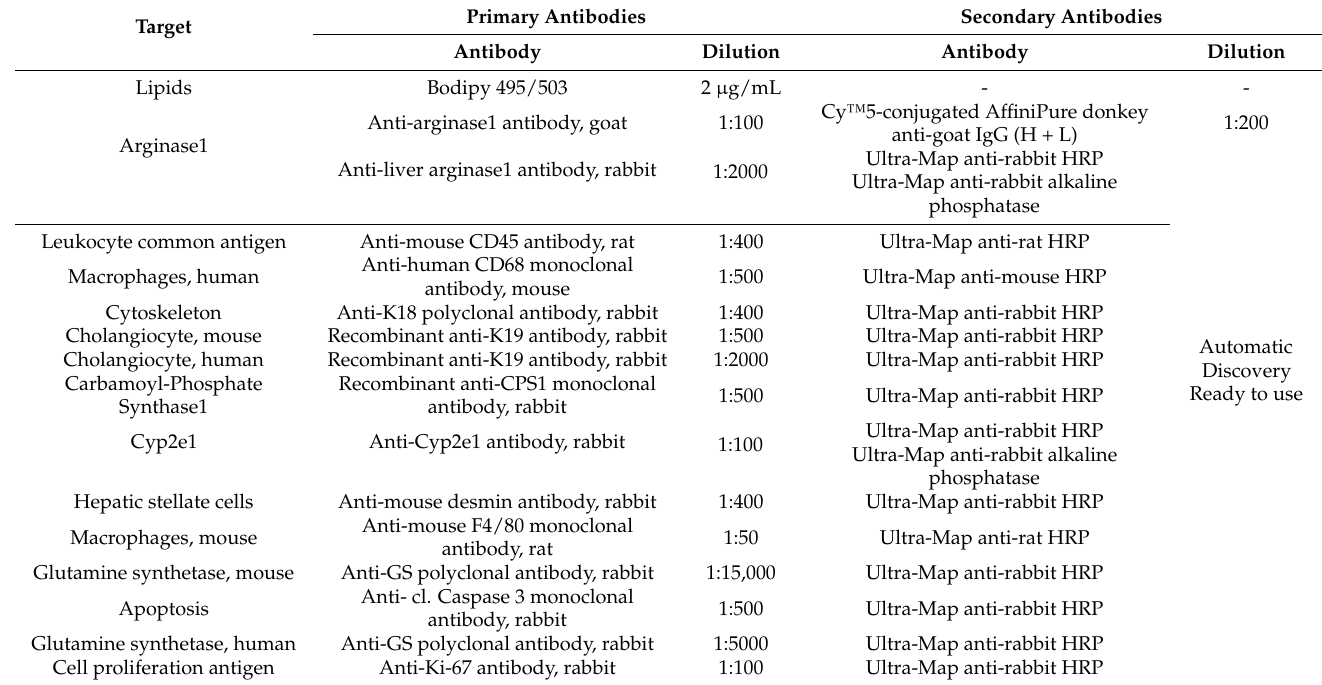
Table 5. Antibodies/dyes used for immunohistochemistry